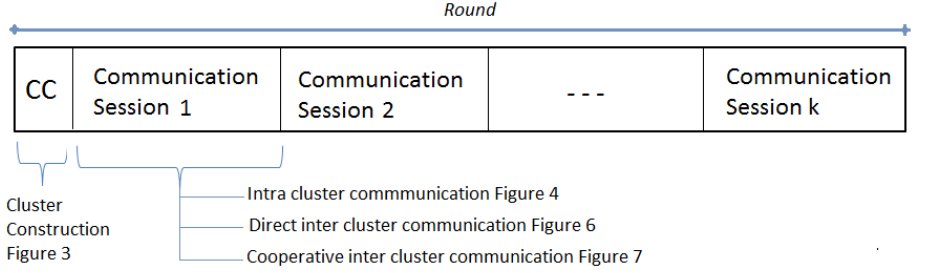
Figure 2. MAC Communication Round.